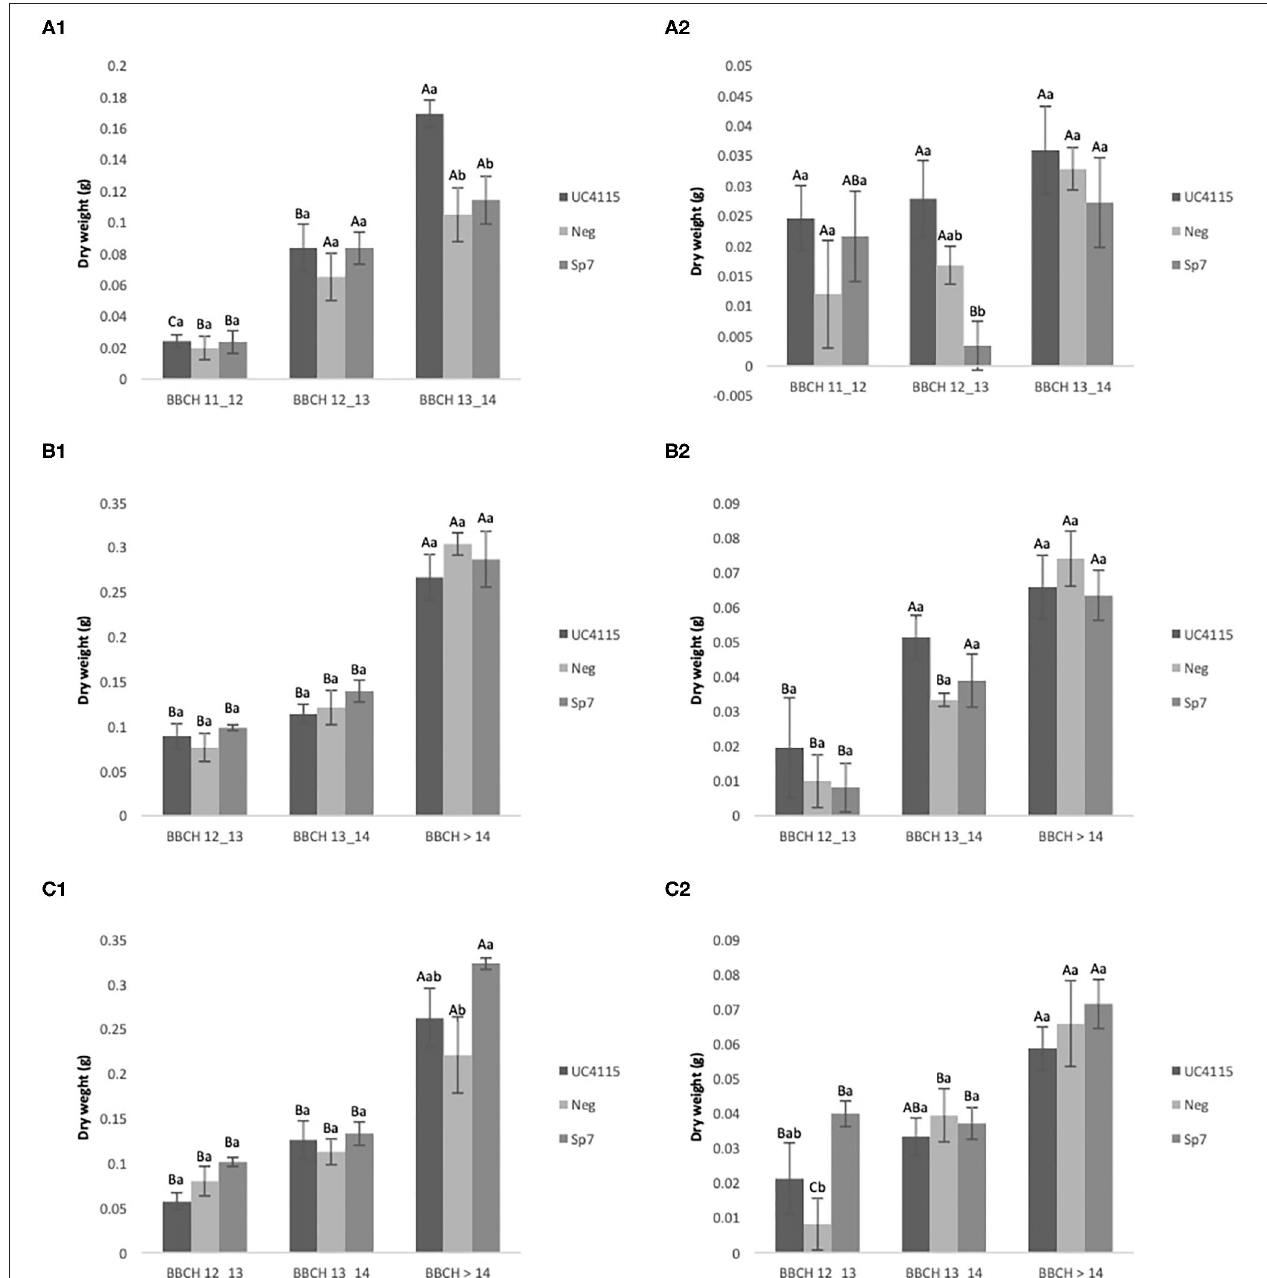
FIGURE 3 | Organic experiment. Evolution over time of tomato plant above-ground biomass (A1,B1,B2) and below-ground biomass (A2,B2,C2) after inoculation with UC4115, Sp7, and negative control at seed level (A1,A2) , root level (B1,B2) and seed plus root level (C1,C2) . Mean values ± standard deviation. Capital letters indicated differences among physiological state (BBCH) of tomato plant within the same inoculation; lowercase letters indicate differences among different inoculations within the same physiological state.